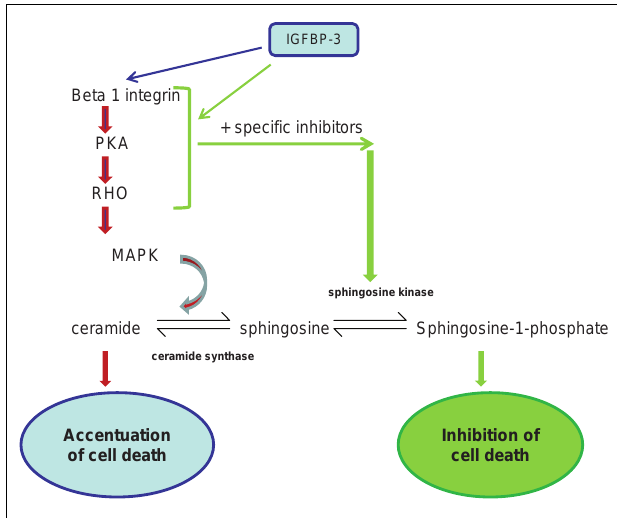
FIGURE 7 | Signaling molecules involved in the pathway by which IGFBP-3 enhances apoptotic triggers: Inhibition of which can lead to IGFBP-3 having the opposite effect. IGFBP-3 is able to have either enhancing or inhibiting effects on apoptotic triggers depending upon the